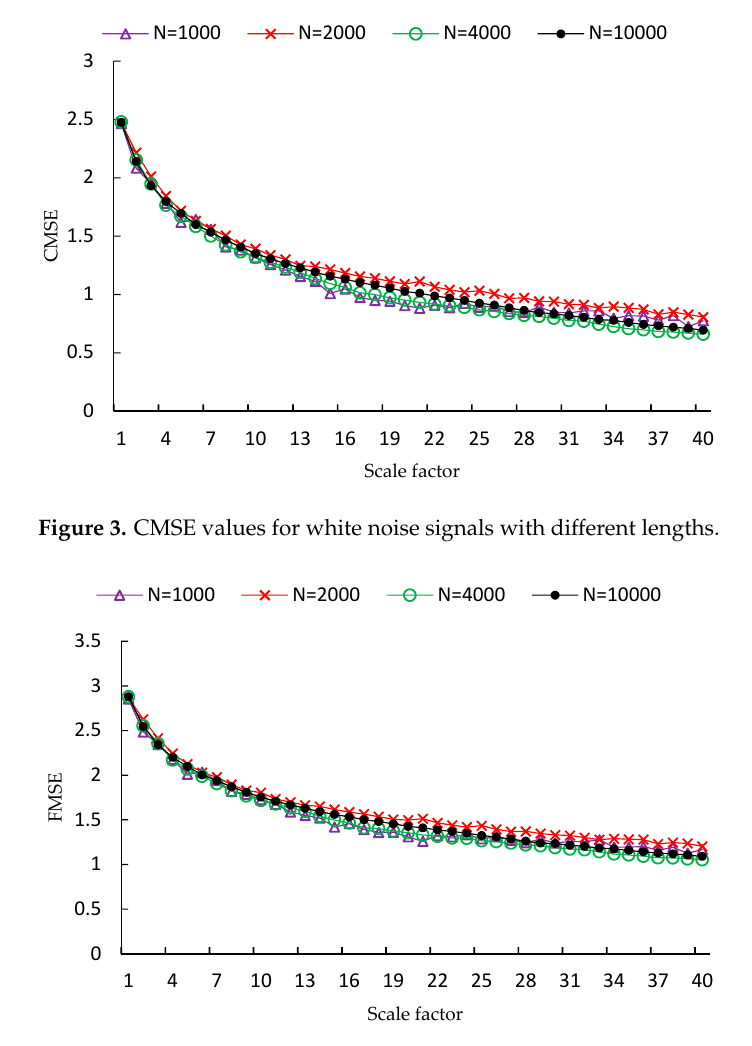
Figure 4. FMSE values for white noise signals with different lengths.